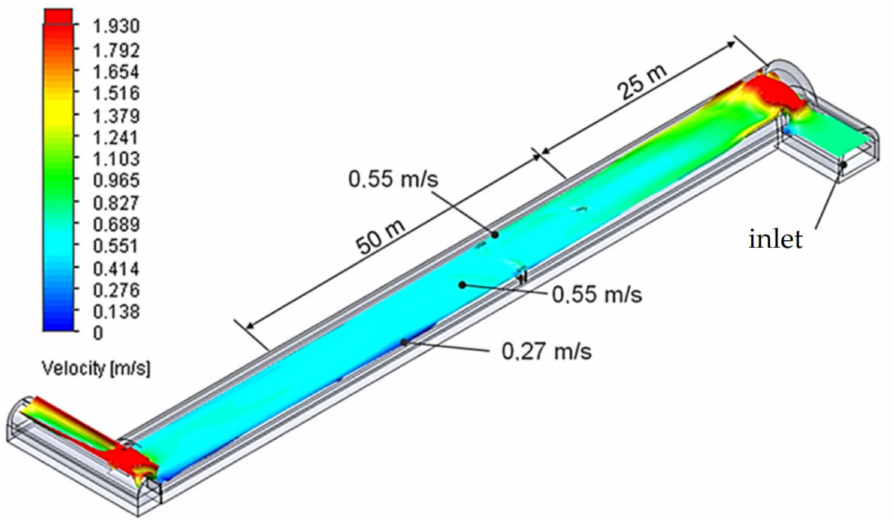
Figure 10. Air velocity along the underground excavation.